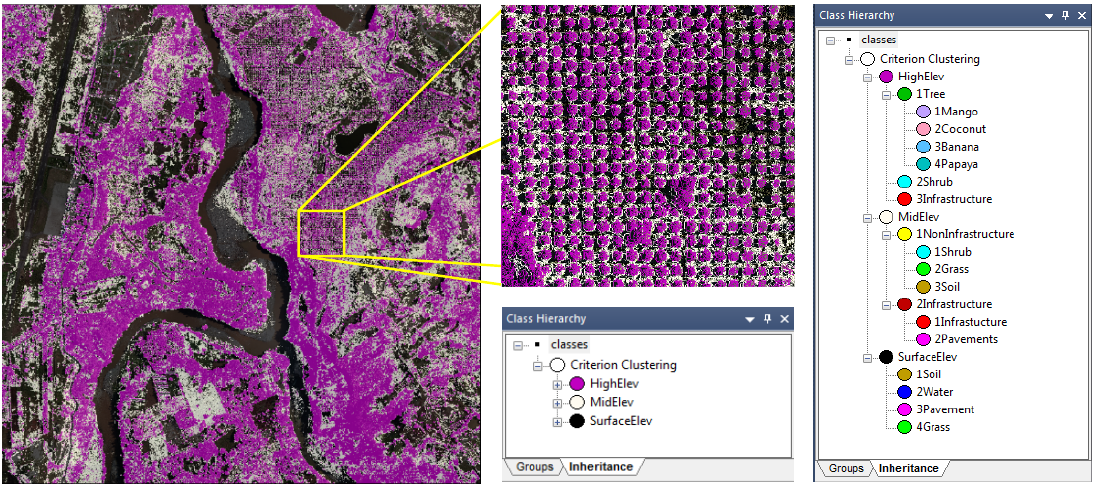
Figure 3. General Segmentation breakdown and utilization of Inheritance type class hierarchy